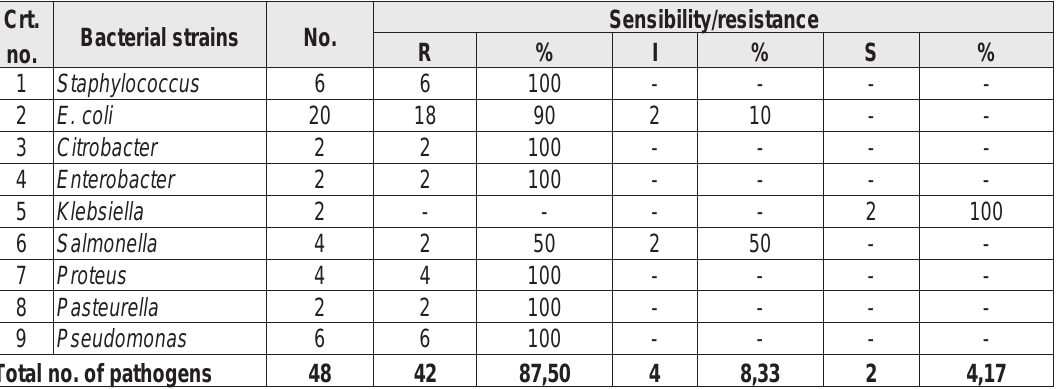
Table 2. Susceptibility/resistance to streptomycin